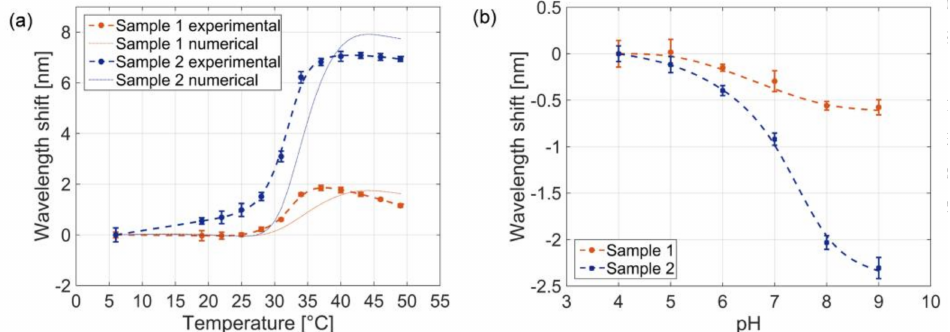
Figure 7. Resonant wavelength shift as function of solution temperature at pH 4 ( a ) and as function of the solution pH at 32.5 ◦ C, of the sample 1, with coverage factor of 21% ( a ) and sample 2, with coverage factor of 92% ( b ). The error bars represent one standard deviation evaluated on 5 acquisitions. The dashed lines were obtained with a smoothing spline